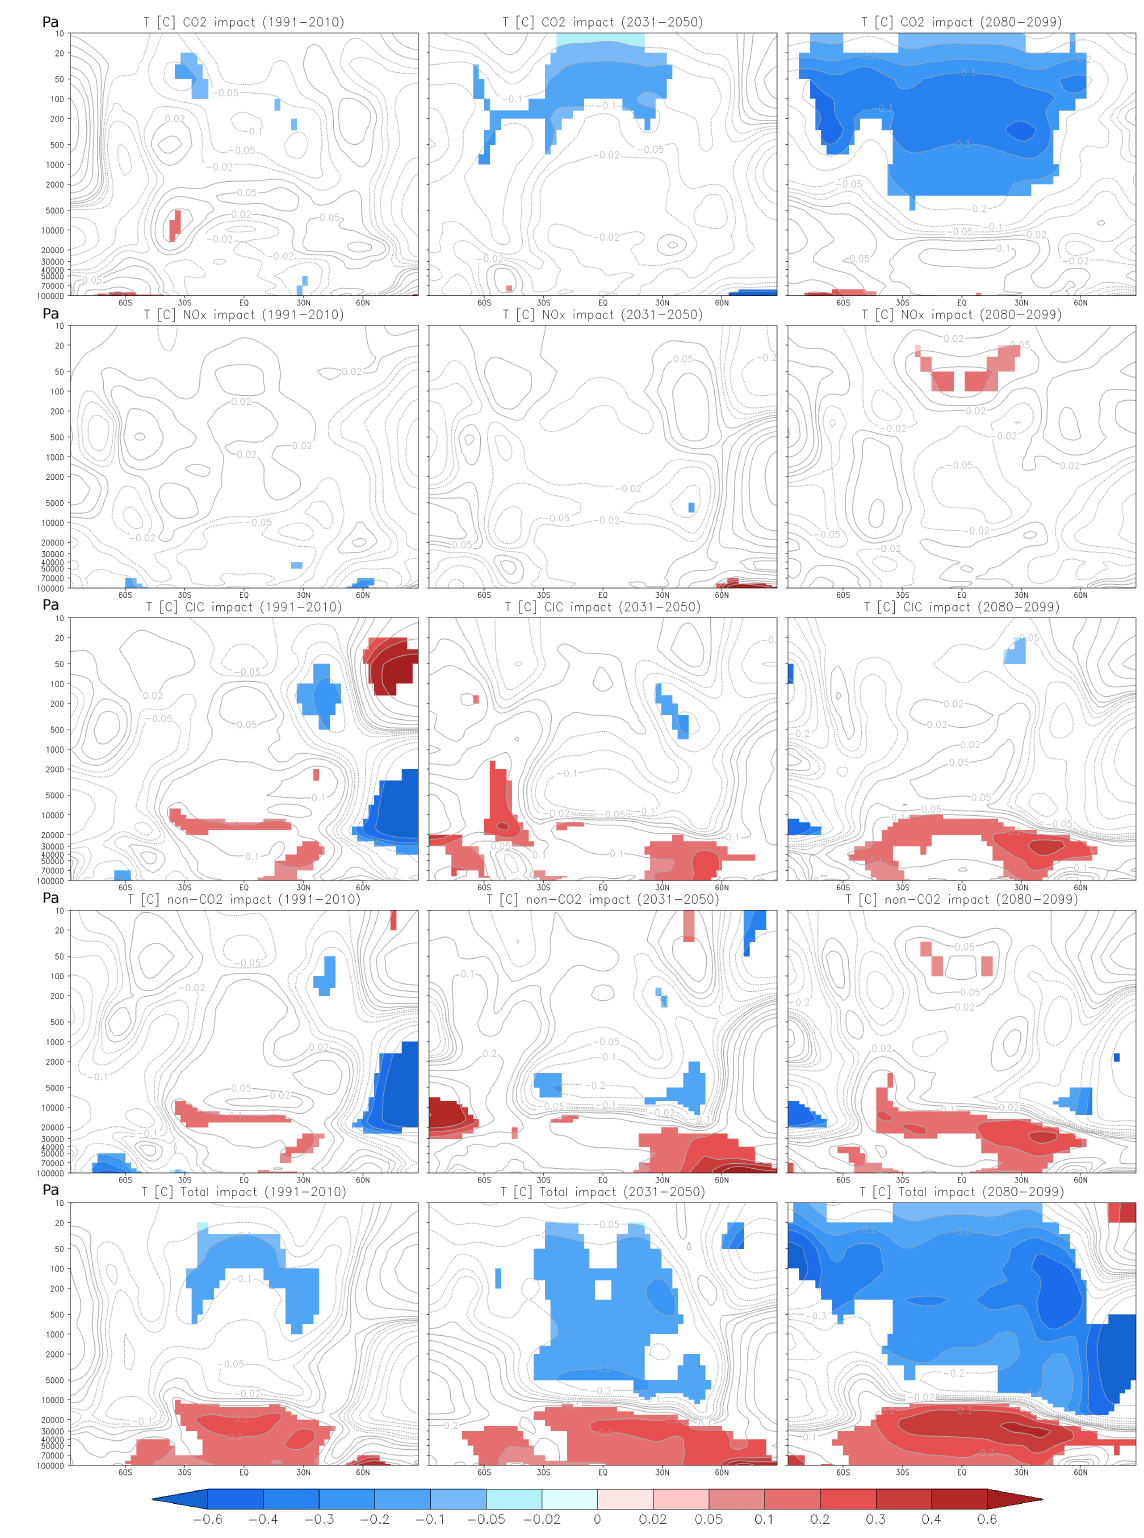
Fig. 11. Zonally averaged impact of aviation emissions on temperature over 1991–2010 (left column), 2031–2050 (middle column) and 2088– 2099 (right column). The rows (from top to bottom) represent the impact of CO 2 , of NO x emissions, of CIC, of the non-CO 2 emissions and of the all the emissions considered (Total impact). The shaded areas represent statistically significant changes at the 95% level of confidence when applying a t-test. The vertical axis corresponds to pressure in